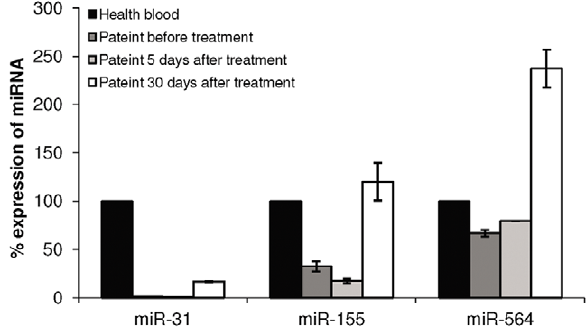
Figure 4. Expression analysis of miRNAs in a CML patient before and during treatment with imatinib. Expression analysis of miR-31, miR-155 and miR-564 in a CML patient at diagnosis an on day 5 of imatinib treatment at a dose of 100 mg/day (for the first week of treatment) and on day 30 of imatinib treatment at a dose of 400 mg/ day (from the fourth week of treatment and thereafter). Expression was analyzed by miR–qRT-PCR. Shown is the percentage of miRNA expression normalized to U6-snRNA 6 SEM from at least 3 experiments.